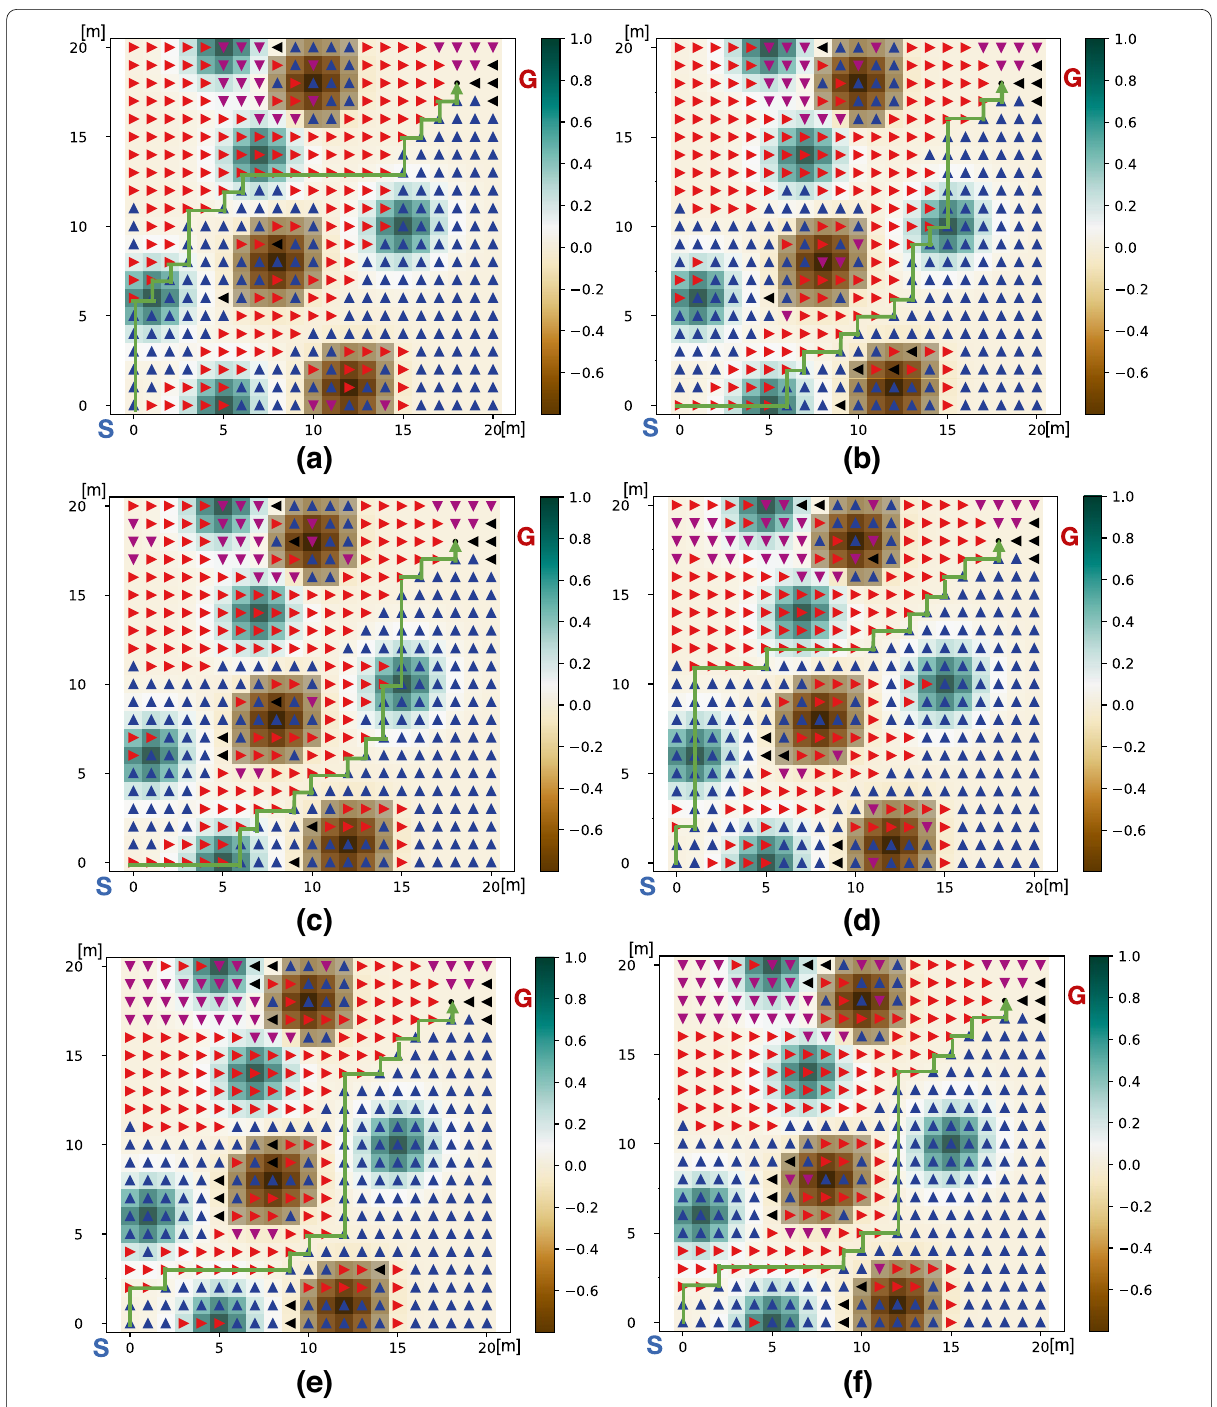
Fig. 4 The path planning results on hard ground (1); a : ( w 1 , w 2 ) = ( 0,1 ) , b : ( w 1 , w 2 ) = ( 0.1,0.9 ) , c : ( w 1 , w 2 ) = ( 0.2,0.8 ) , d : ( w 1 , w 2 ) = ( 0.3,0.7 ) , e : ( w 1 , w 2 ) = ( 0.4,0.6 ) , f : ( w 1 , w 2 ) = ( 0.5,0.5